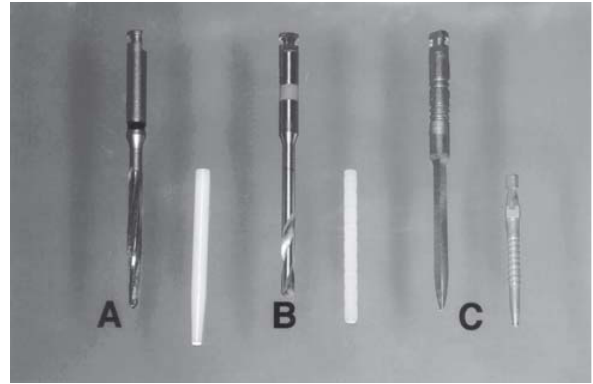
FIGURE 1- Post systems used in the study. A- Zirconia Posts; B- Fiber Reinforced Resin Composite Posts and C- Titanium